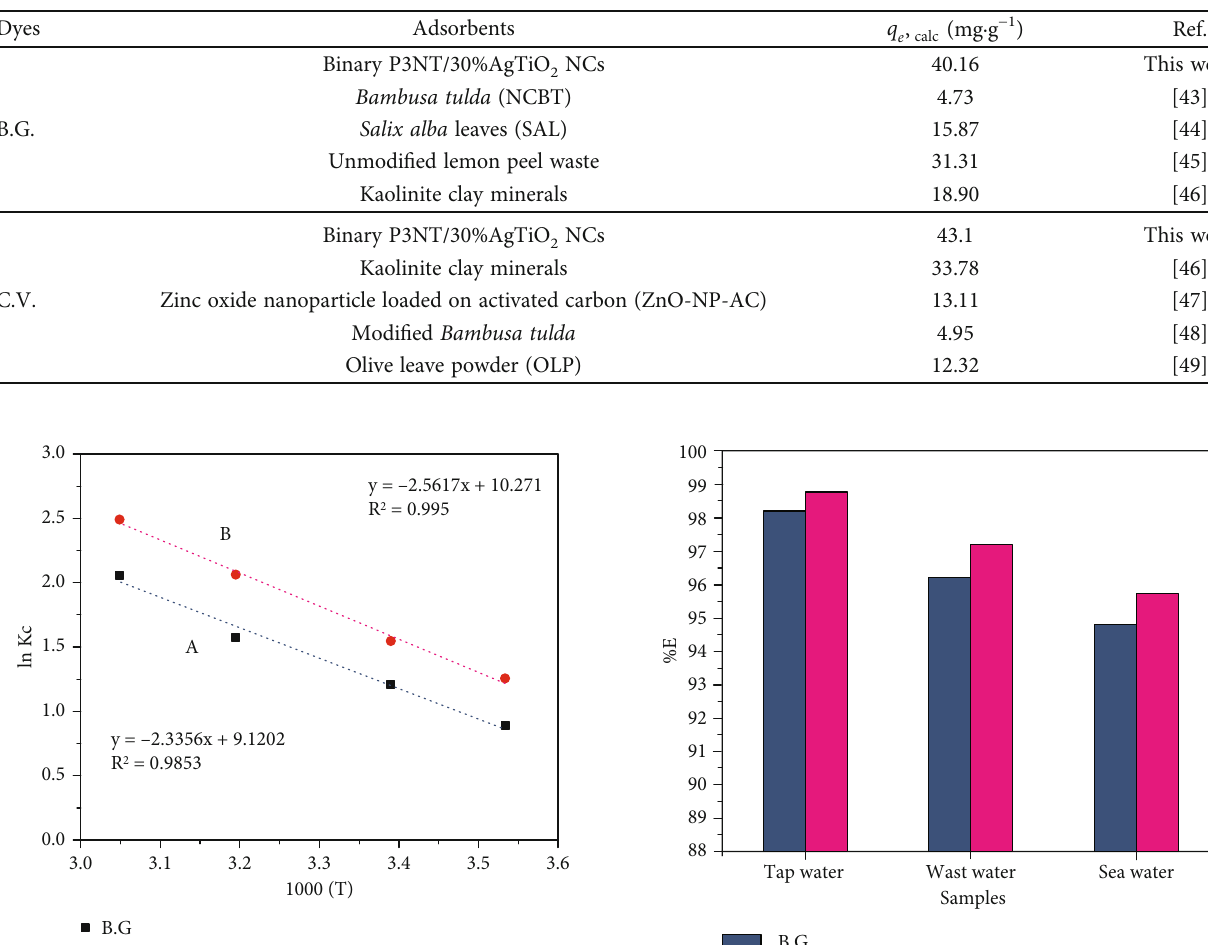
e with various adsorbents.